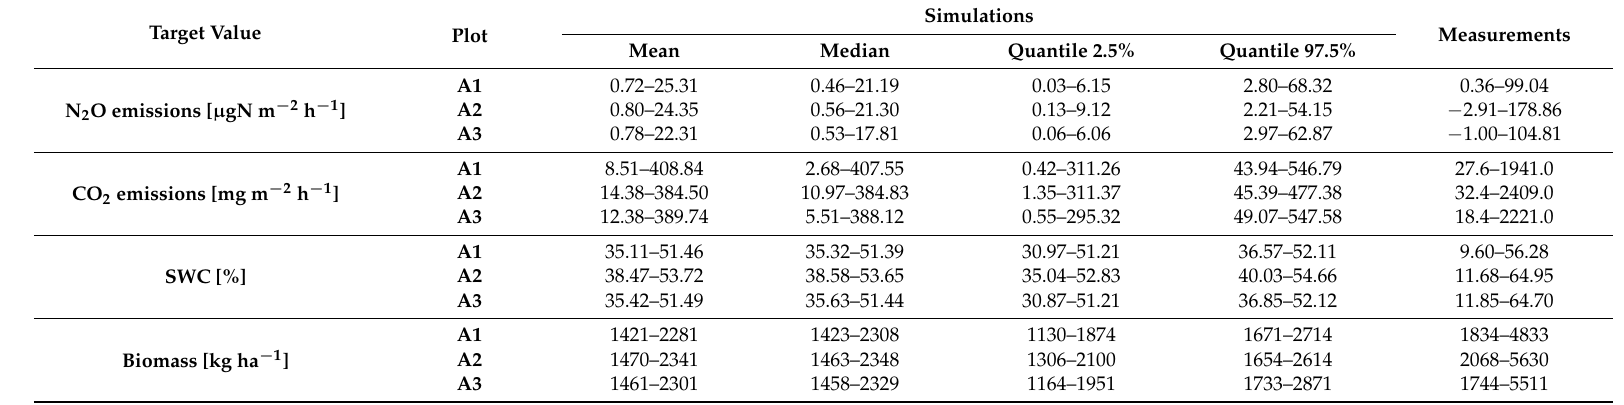
Table A3. Ranges of the statistical characteristics and measured data for noGW simulations during the investigation period. Mean, median and quantiles of the confidence intervals have been calculated for each time point of the period 1997–2009 (1998–2009 for CO 2 emissions). The depicted values show the ranges in which the statistics and measured data varied over time. Square brackets show the physical units of the target